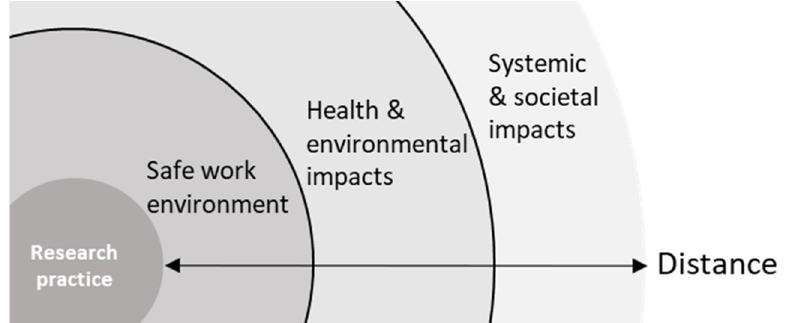
Figure 3. Identification of a second boundary between knowable downstream impacts on health and environment and uncertain systemic and societal downstream impacts.